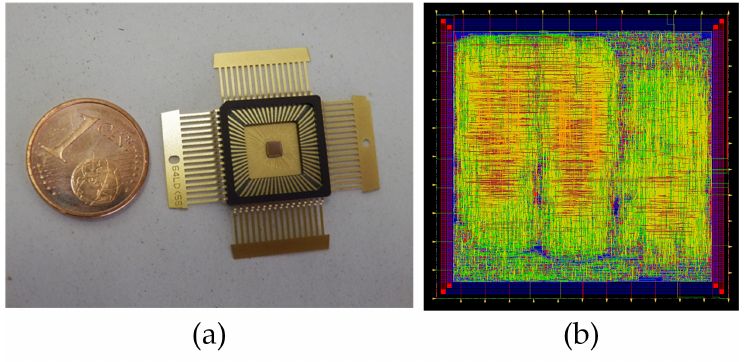
Figure 1. ( a ) ASIC; ( b ) ASIC’s layout.